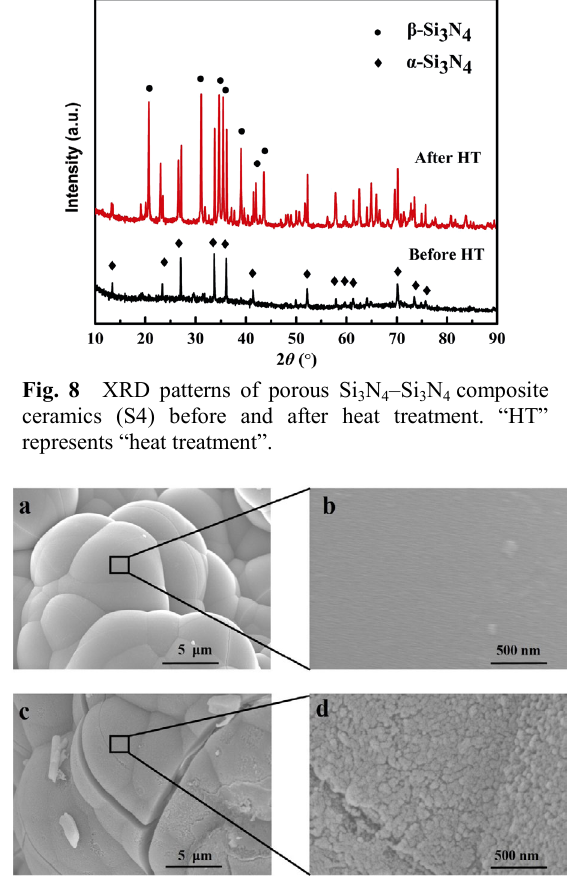
Fig. 9 Micrographs of porous Si 3 N 4 –Si 3 N 4 composite ceramics (S4): (a, b) before heat treatment and (c, d) after heat treatment.